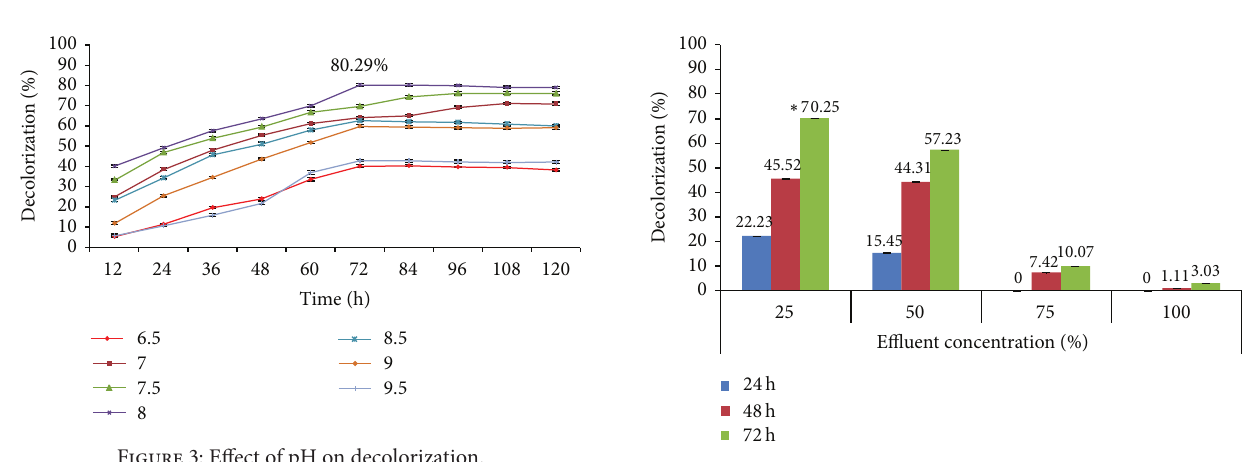
Figure 5: Effect of different concentrations of tannery effluent on seed germination. All values are expressed as mean ± SE, ∗ 𝑃 < 0.05 (significant as compared to 50%, 75%, and 100%